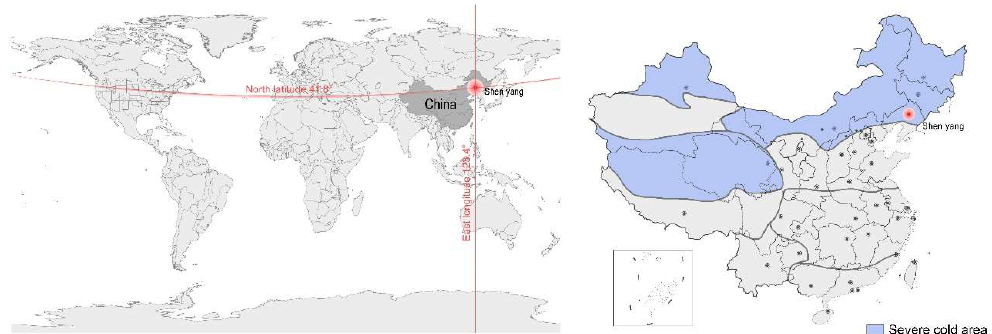
Figure 1. Location of Shenyang and the severe cold area of China.